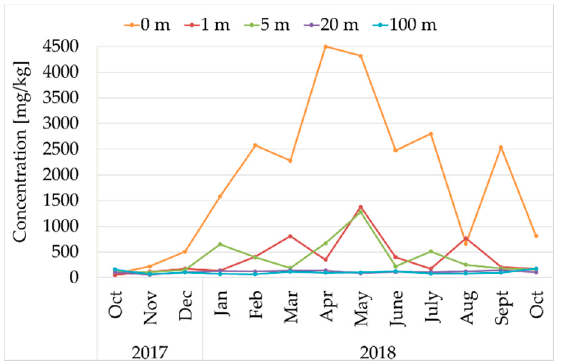
Figure 8. Chloride concentrations in soils at Site A measured at five distances from the motorway [mg/kg].